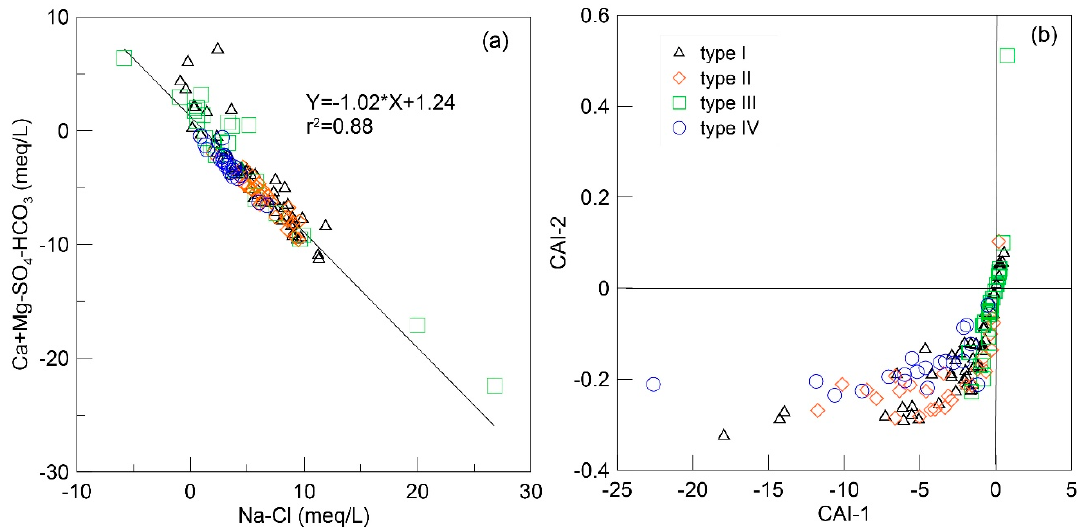
Figure 7. Scatterplots of ( a ) Ca + Mg–SO 4 –HCO 3 versus Na–Cl and ( b ) chloro-alkaline indices showing the groundwater cation exchange process.